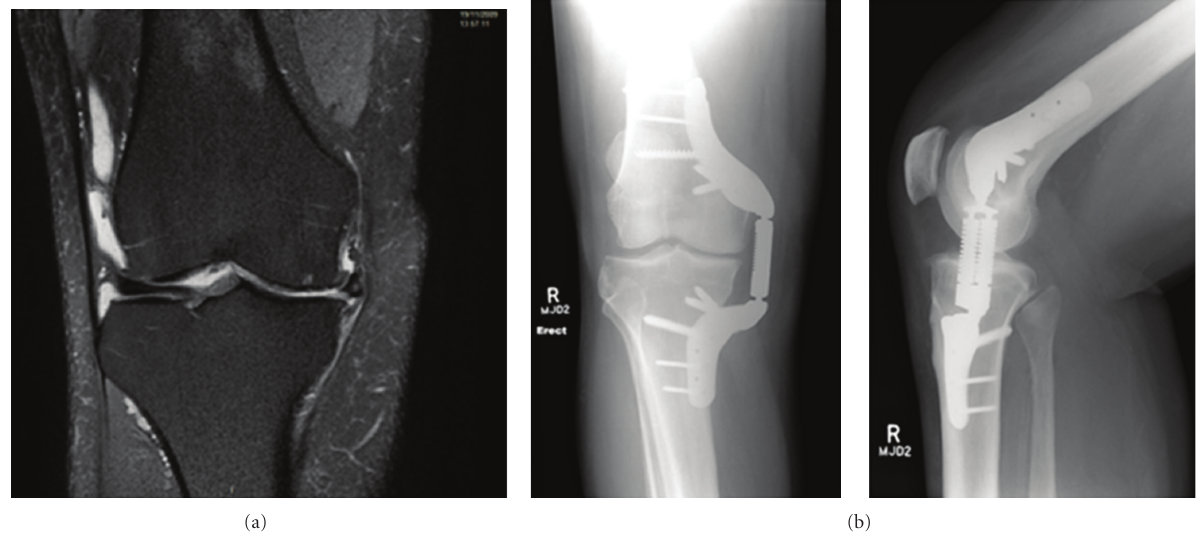
Figure 4: (a) Anterior view of the right knee with pre-treatment magnetic resonance imaging (a) and anterior (left) and medial (right) 1-year radiographs demonstrating the KineSpring System in situ